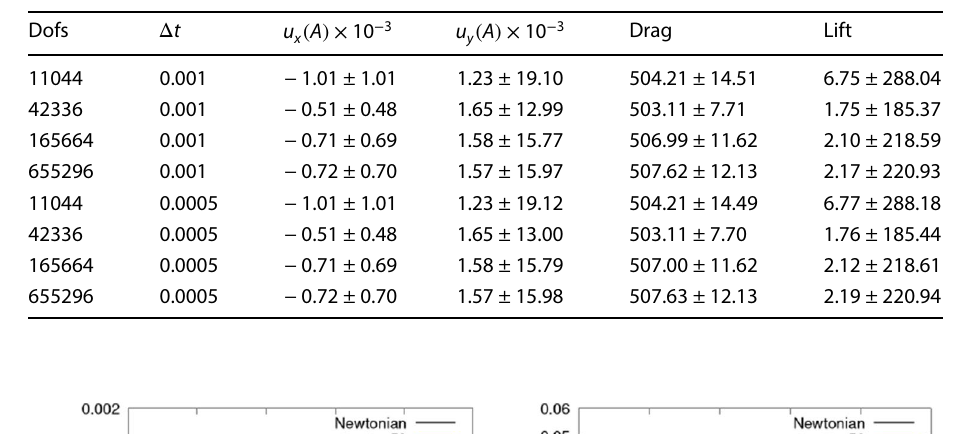
Fig. 8 Plots of the functionals for the Newtonian FSI3 case and two viscoelastic cases with varying shear moduli 𝜇 1 and 𝜇